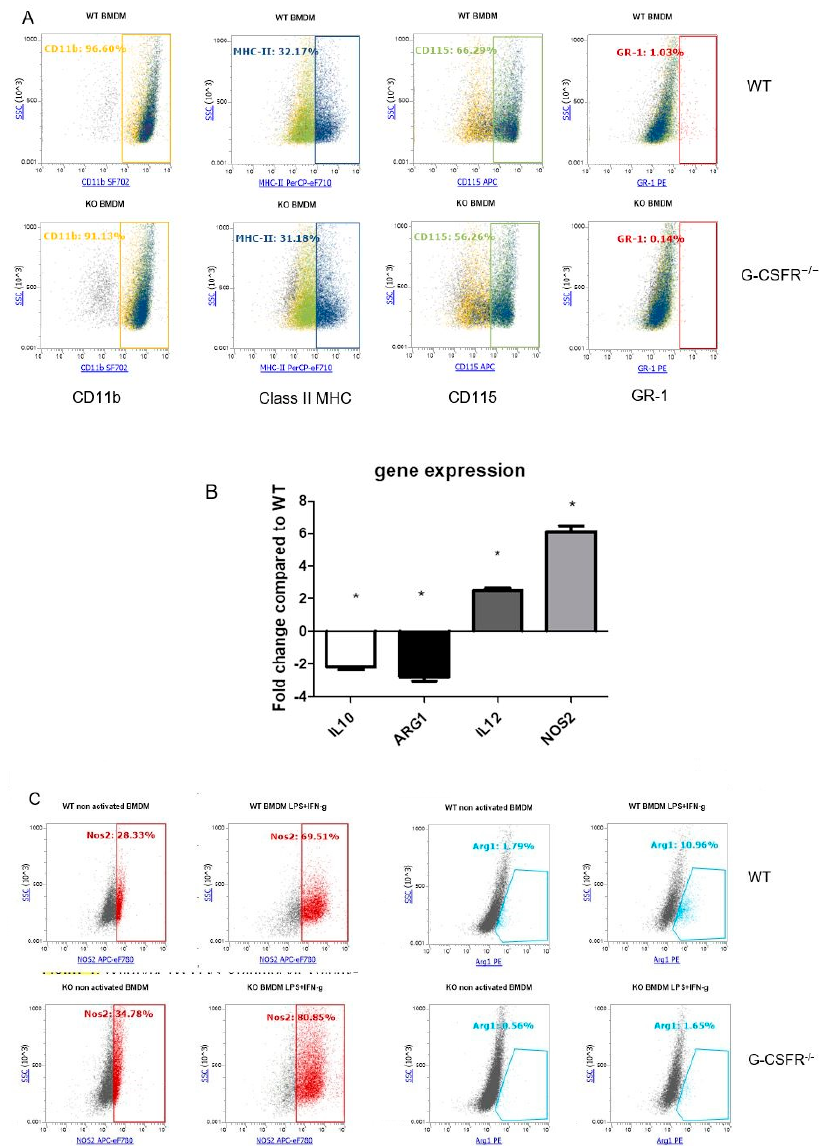
Figure 1. WT vs G-CSFR − / − BMM express similar macrophage markers, but altered cytokine and NOS2 expression as shown by ( A ) Flow cytometry analysis for CD11b, MHC-II, CD115 and GR-1 and ( B ) Real-Time PCR analysis showing in the absence G-CSFR, there is downregulation of IL-10 and ARG-1 and upregulation of IL-12 and NOS2 mRNA levels compared to WT. ( C ) Results for ARG-1 and NOS2 were confirmed by flow cytometry showing increased NOS2 and reduced ARG-1 in LPS + IFN γ activated G-CSFR − / − BMMs compared to WT. n = 6, * p <